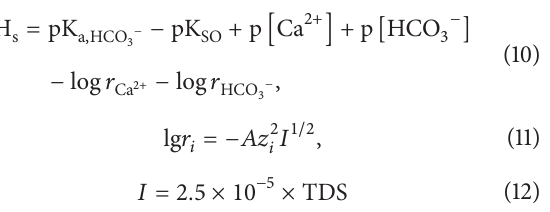
H 2 transfer across the micropores of the membrane.